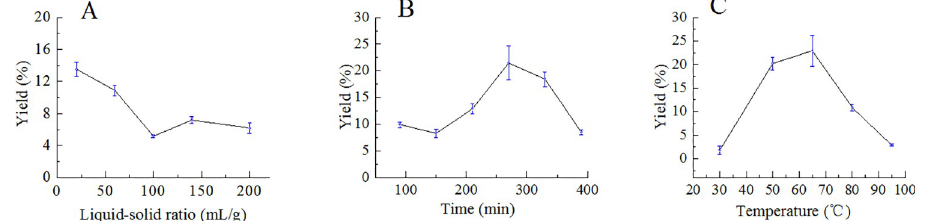
Fig 1. Effects of liquid-solid ratio (A), extraction time (B), and extraction temperature (C) on the yields of total sugars from C . decumbens